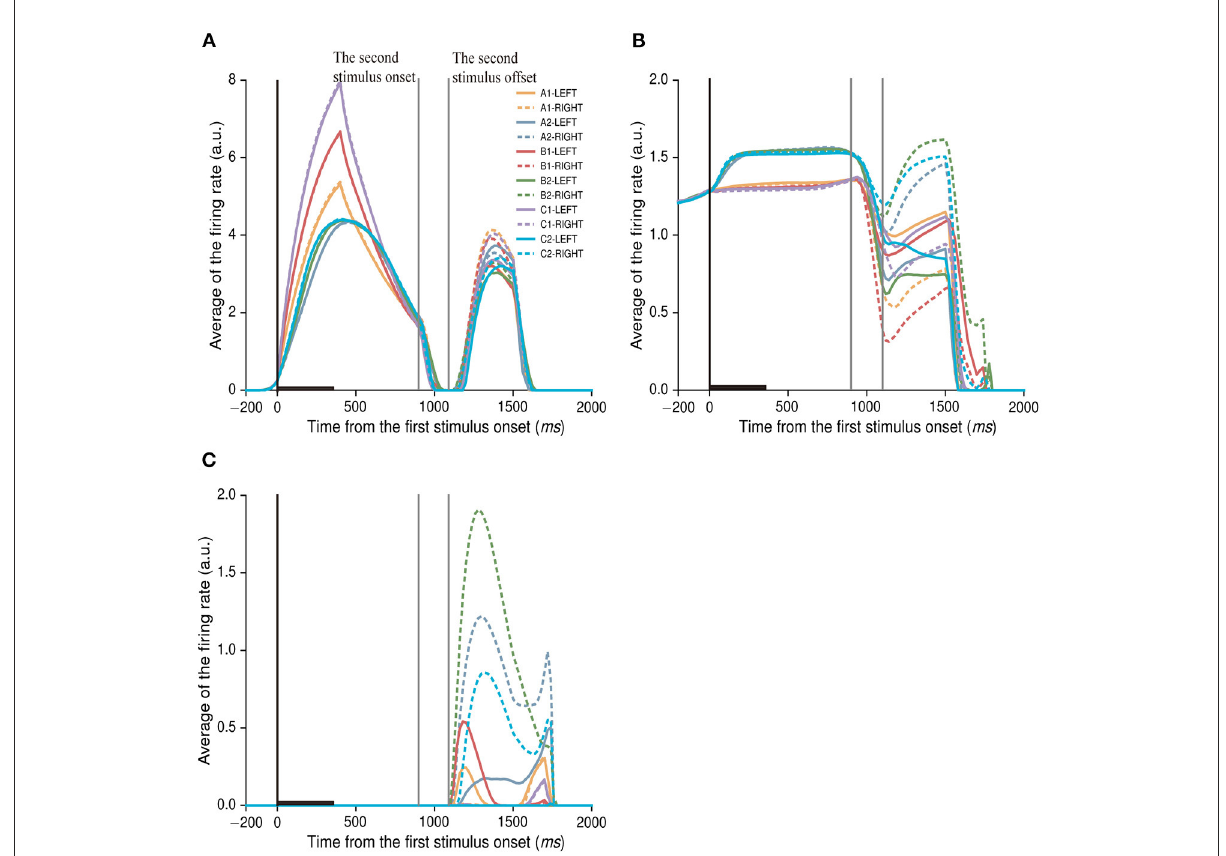
FIGURE9 The activity of neurons related to action choices. Here, the two gray lines indicate the second stimulus period, after the second stimulus period, the network model chooses an action (left or right) during the first decision period. The activity of each neuron is aligned on the first stimulus onset, and is sorted with stimulus-position conditions. The same figure legends are used in (A–C) . (A) An example neuron shows only stimulus-related activity in the first stimulus and delay periods, no differential activity to actions (or positions). (B) An example of neuron shows not only category-related activity in the first stimulus and delay periods, but also activity related stimulus-action combinations after the second stimuli offset. (C) An example of neurons shows only stimulus-action related activity after the second stimuli offset, no stimulus-related activity either in the first stimulus period or in the delay period. The averaged firing rate of one neuron indicates its firing rates that are averaged across all